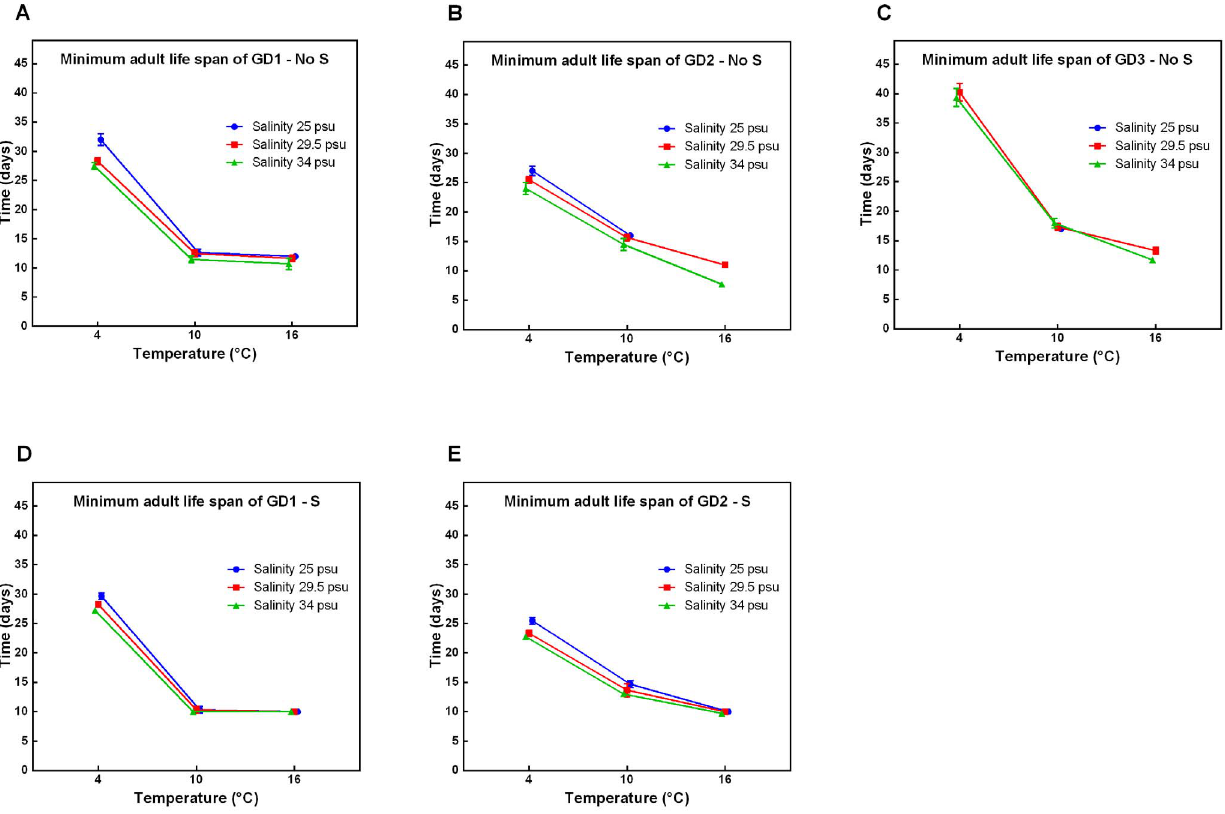
Figure 4. Minimum adult life span under changing environmental conditions. Minimum adult life span in relation to temperature and salinity of cryptic Halomonhystera disjuncta species: GD1 (A, D), GD2 (B, E) and GD3 (C), in the absence (No S; A–C) and presence (S; D–E) of sulphide. The minimum adult life span corresponds to the day after the start of the experiment on which the first inoculated nematode died. Data shown are mean values 6 1stdev of 3 or 4 replicates per treatment. No results were obtained for GD3 in the presence of sulphide because inoculated nematodes died within the first 1–2 minutes after adding Su. Some data points are missing because the experiment was stopped before the death of any of the inoculated